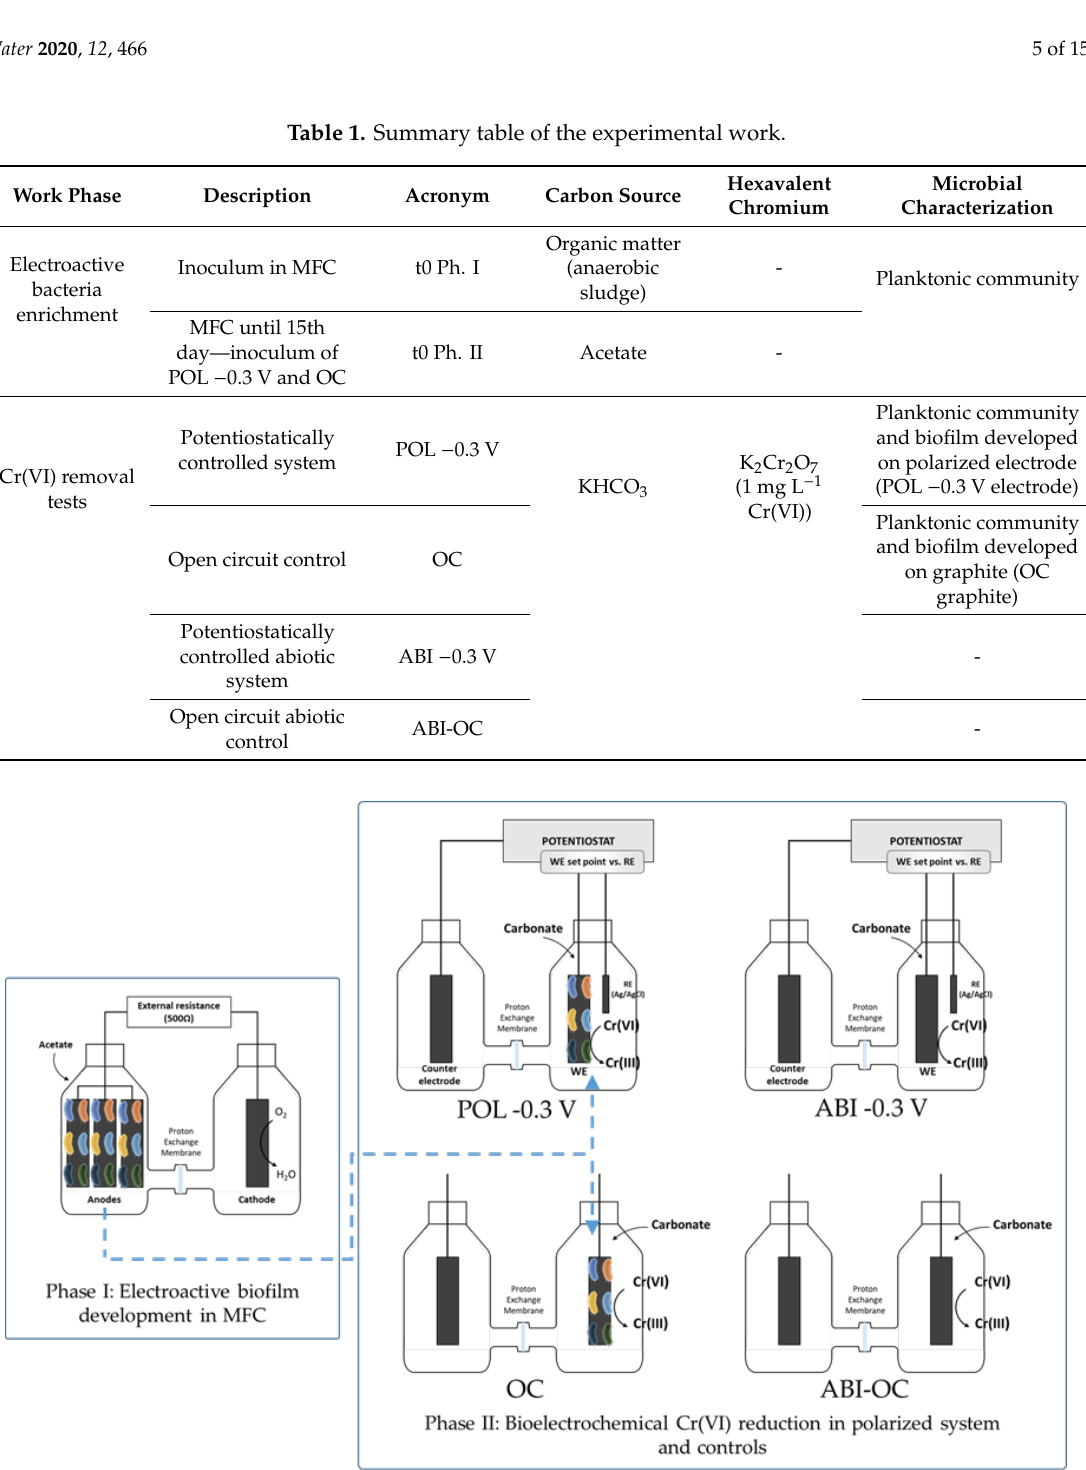
Figure 2. Conceptual model of the experimental work.